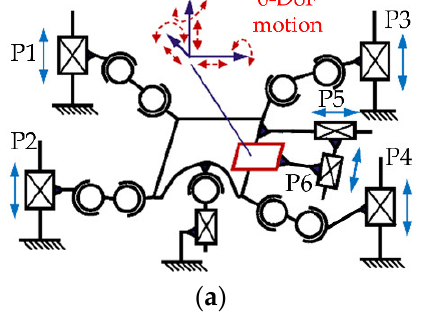
Figure 3. The mechanism of the training platform and its motion. ( a ) A 6-DOF serial–parallel mech- anism of the training platform; ( b ) spatial motion of the training platform.